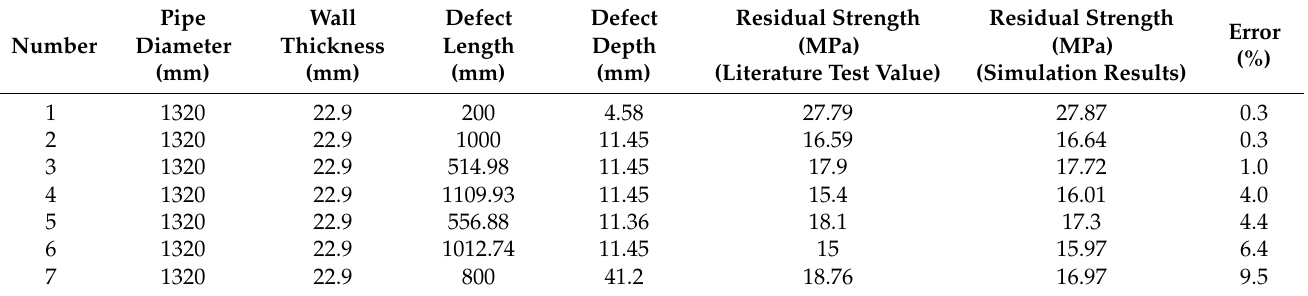
Table 3. Prediction and comparison of residual strength of pipeline steel under different notch